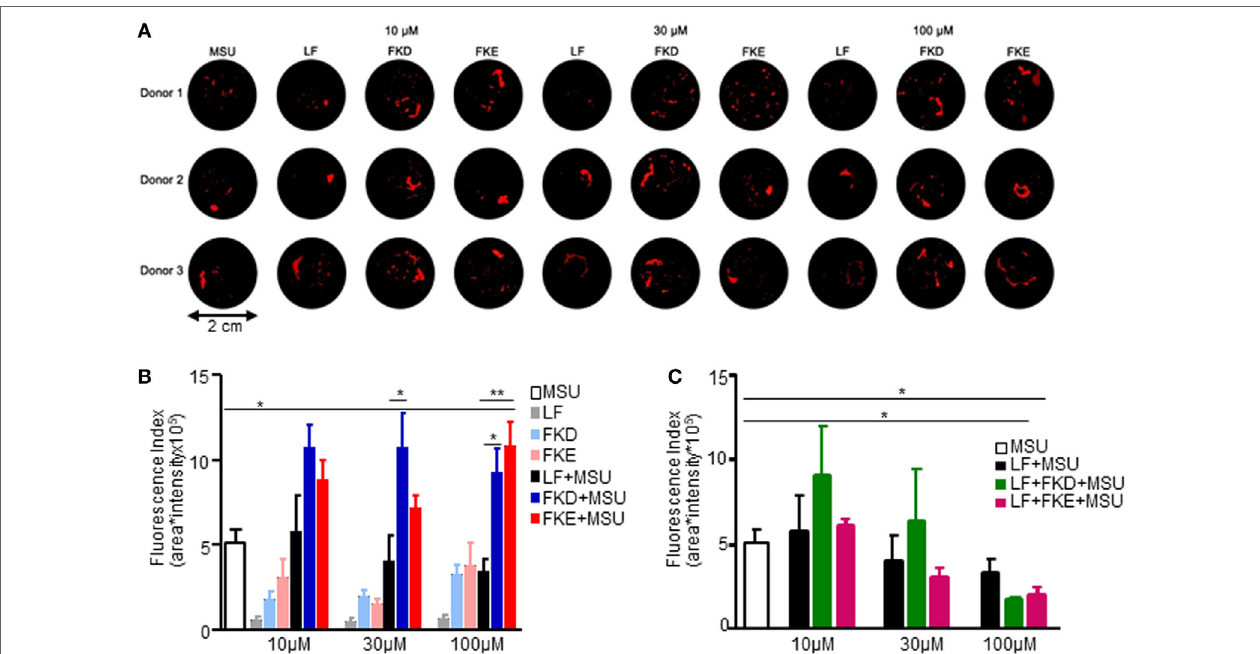
FigUre 6 | Lactoferrin (Lf)-derived peptides induce aggregated neutrophil extracellular traps (aggNETs) formation. Human polymorphonuclear cells (PMN) from three healthy donors were freshly isolated from peripheral blood and seeded in a final cell density of 5 × 10 6 cells/ml. PMNs were incubated with 50 pg/cell monosodium urate crystals (MSU) and/or 10–100 µM Lf (LF) and/or 10–100 µM FKD or FKE peptides and 1 µg/ml propidium iodide solution. NET aggregation was stopped by fixation and aggNETs formed were filtrated through a 40-µM mesh. Macrophotographs with UVB transillumination were captured with a Nikon D700 reflex camera (a) . Averages ± SEM of fluorescence values from three independent donors of the images of control, MSU, and MSU + Lf (B) and MSU + FKD/FKE peptides at the indicated concentrations (c) . **/*indicate statistically significant differences of P ≤ 0.01/ P ≤ 0.05, respectively, by ANOVA with Tukey post hoc